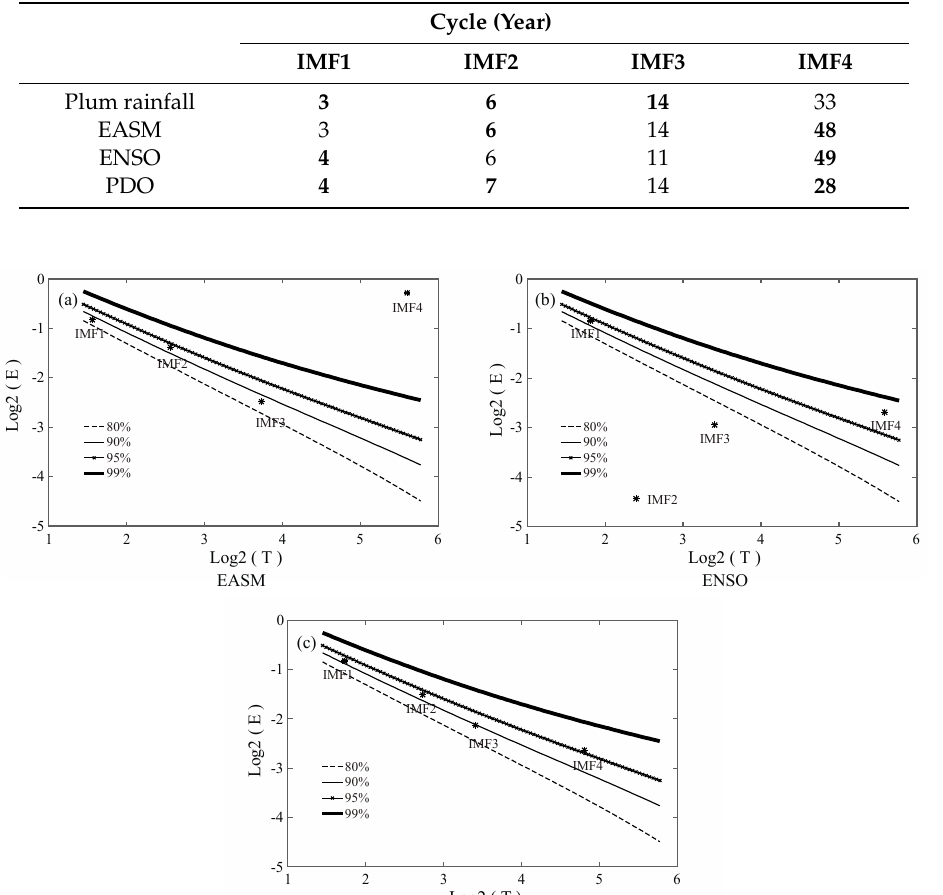
Table 3. The EEMD results of the plum rainfall, EASM, ENSO, and PDO (The numbers in the table represent the cycle of the plum rainfall, EASM, ENSO, and PDO on the four components (IMF1-4), respectively).